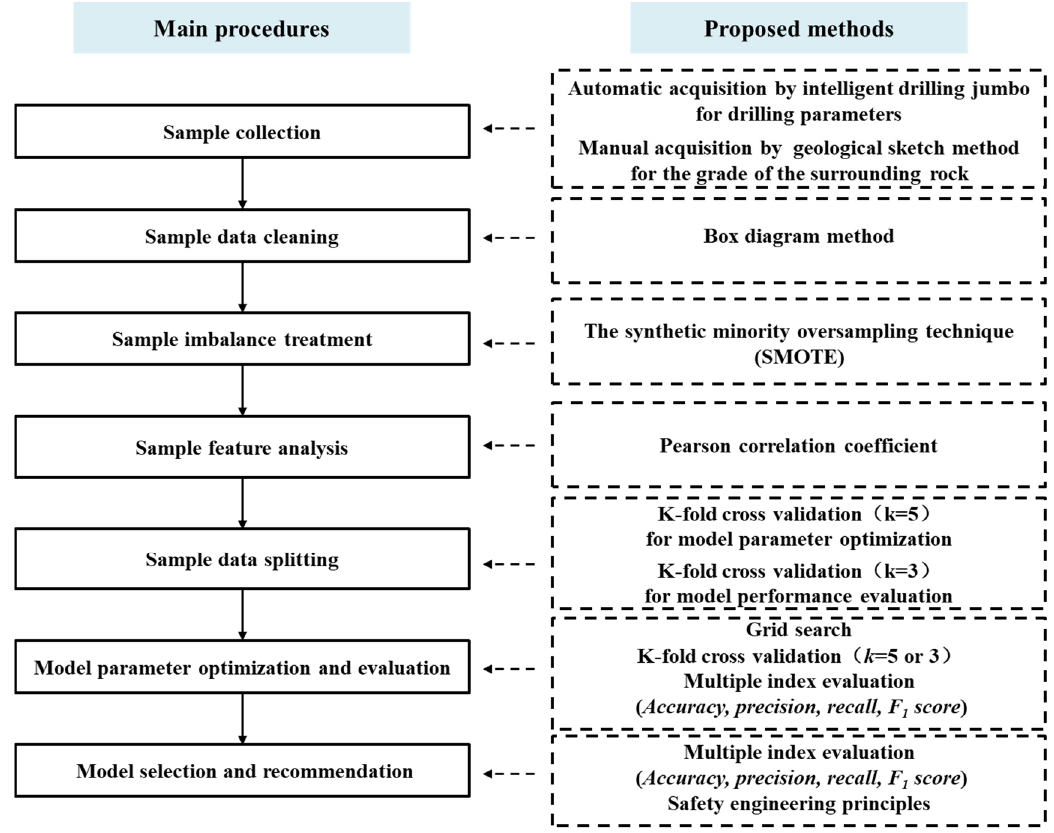
Figure 1. The research flow chart about main procedures and proposed methods .